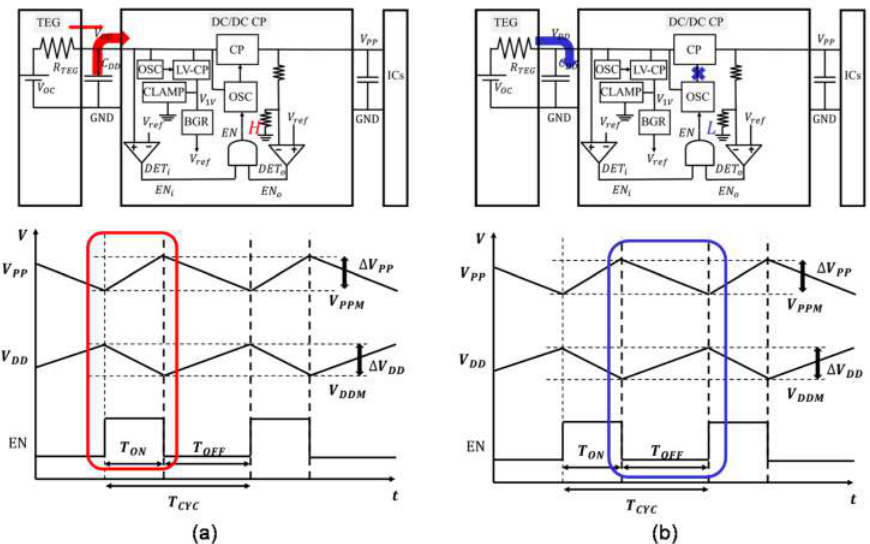
Figure 4. Two phases of the circuit operation. ( a ) Low and ( b ) high input impedance